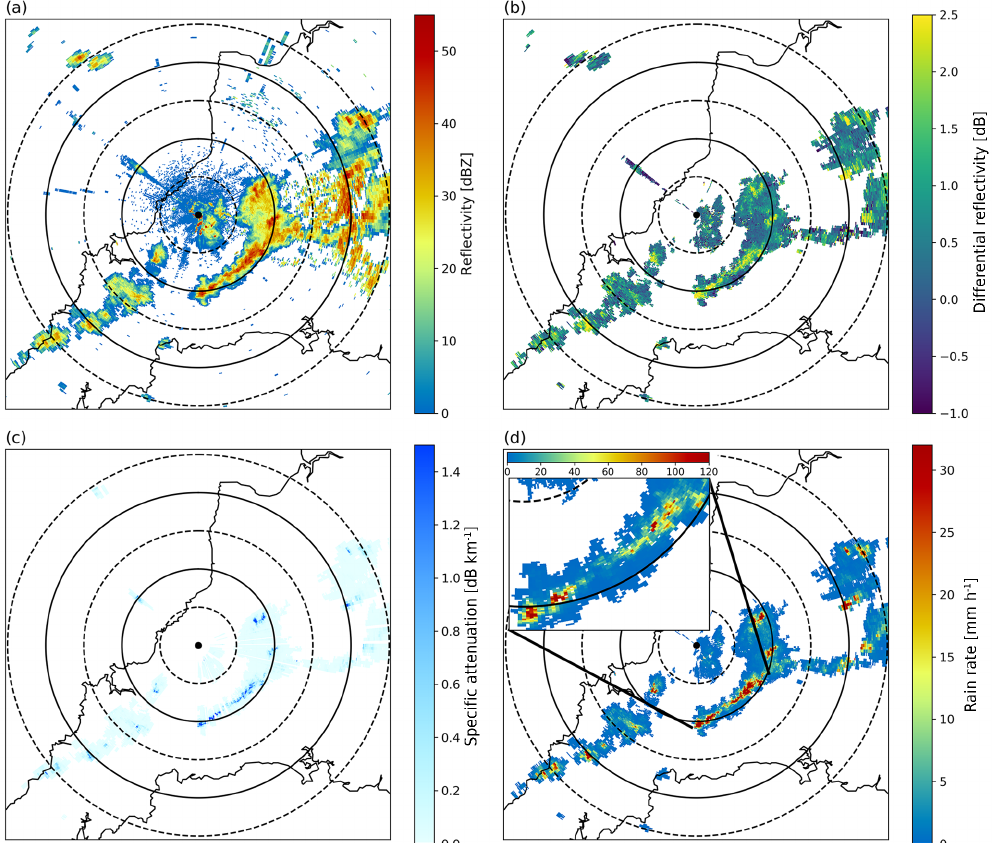
Figure 5. Example of observations made by NXPol (located at the centre black dot) at 0.5 ◦ elevation on 3 August 2013 at 13:32UTC showing (a) calibrated but unfiltered and uncorrected horizontal reflectivity (shown as to display the importance and impact of the data processing), (b) calibrated, filtered and corrected differential reflectivity, (c) specific horizontal attenuation ( A H ) and (d) rainfall rates derived using the Marshall–Palmer relation ( R(Z) = aZ b , with a = 200 and b = 1 . 6). The missing spokes of data in A H are caused by quality control settings in the processing routine that reject radials that do not meet certain thresholds. The sub-panel in (d) shows an expanded section of the line of intense rainfall ( > 120mmh − 1 in some pixels; please note the expanded colour bar to the top of the sub-panel) to the south-east of the radar. Range rings are drawn every